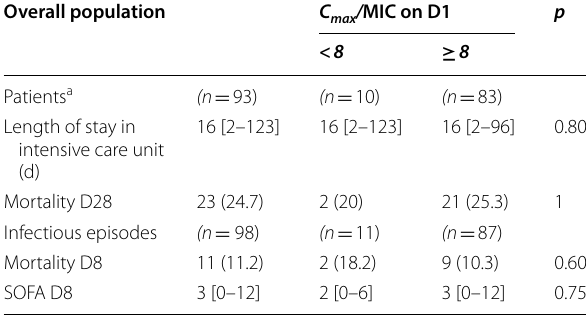
of patients clinical